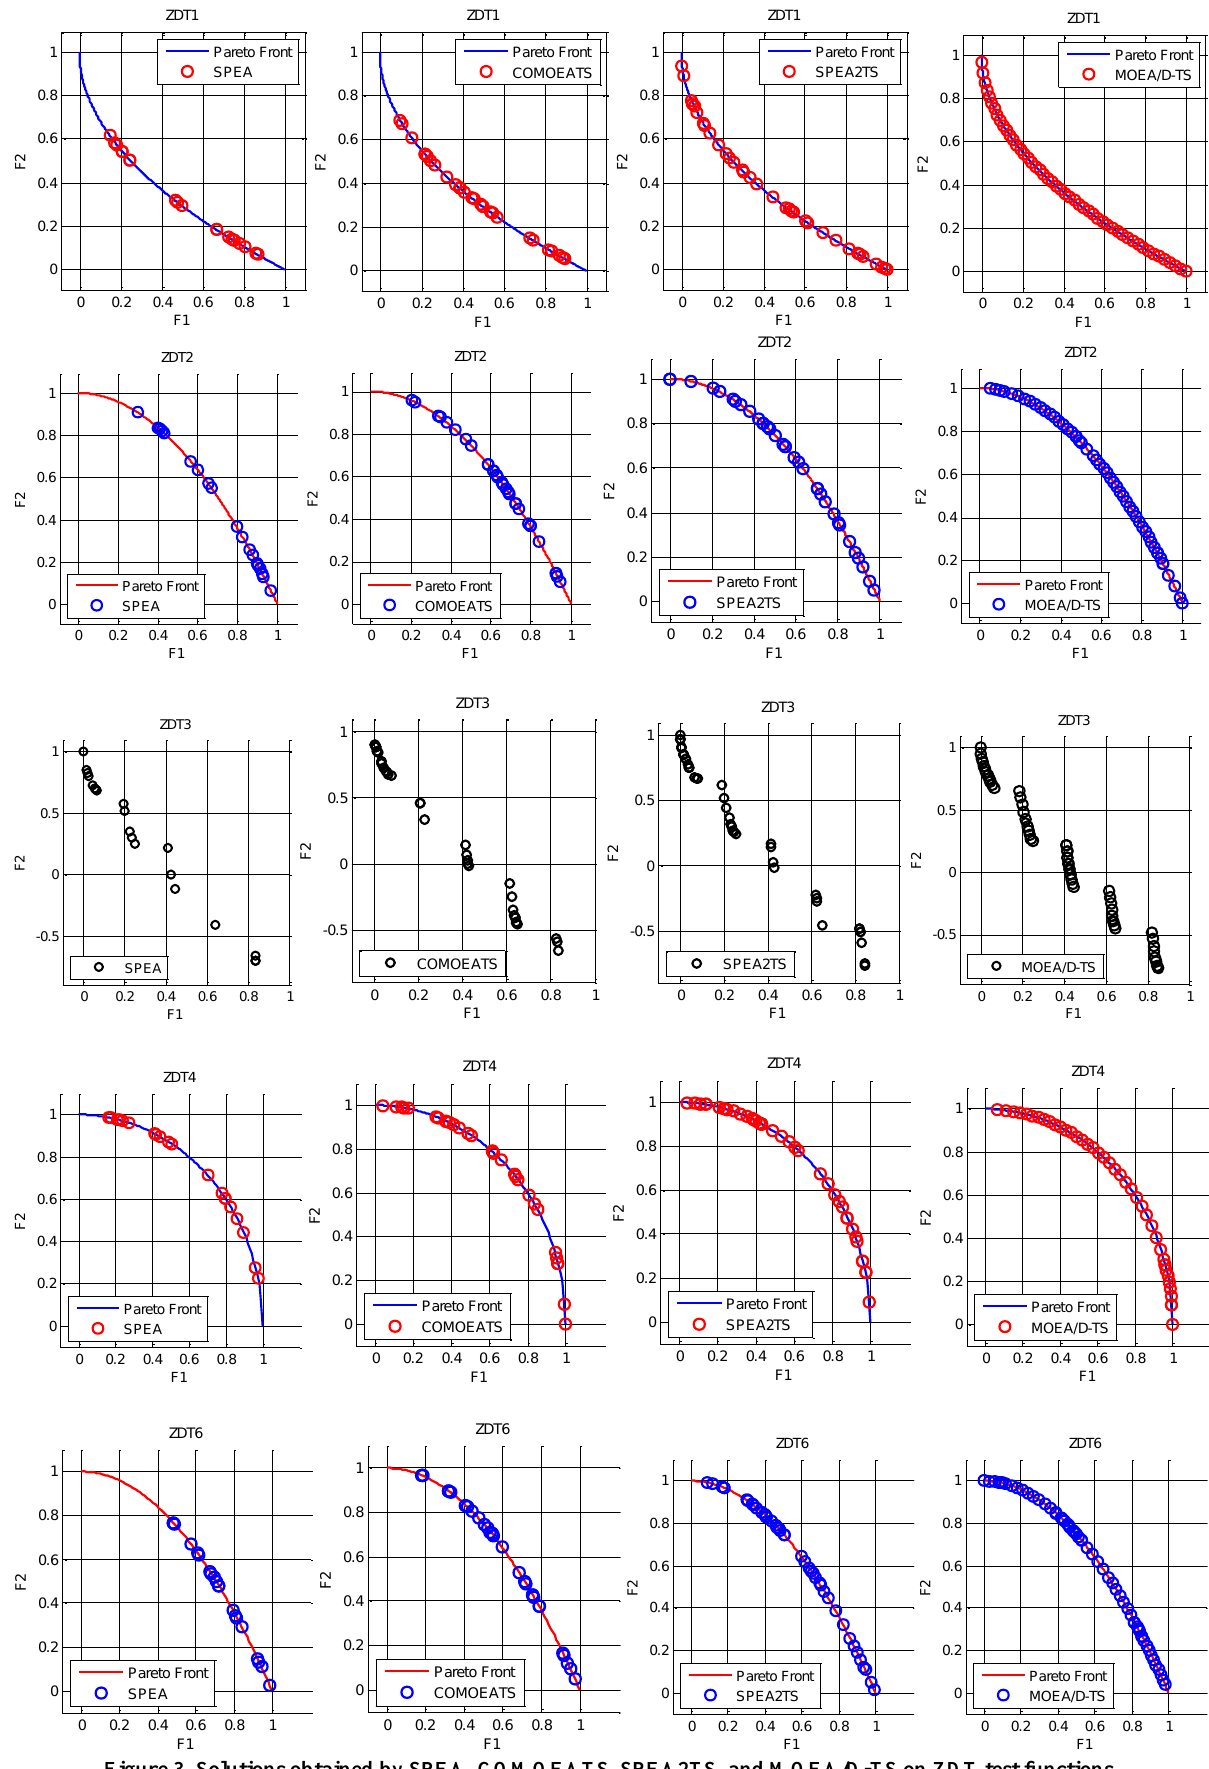
Figure 3. Solutions obtained by SPEA, COMOEATS, SPEA2TS, and MOEA/D-TS on ZDT test